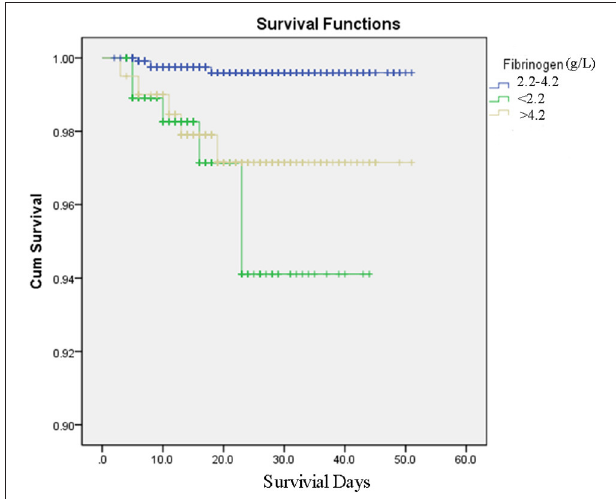
FIGURE 2 | Survival curves produced by Kaplan–Meier analyses for COVID-19 patients with fibrinogen between 2.2 and 4.2 g/L, fibrinogen < 2.2 g/L, fibrinogen over 4.2 g/L.